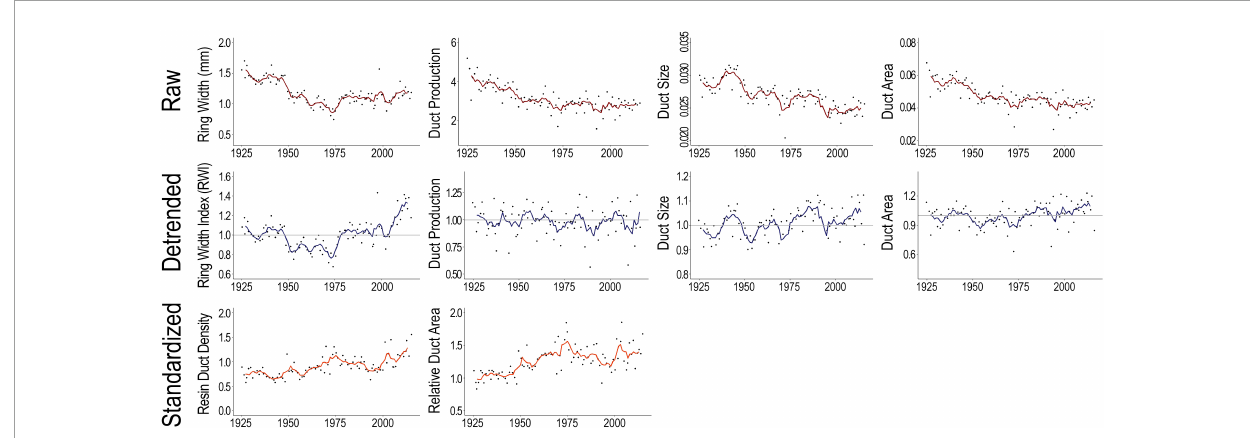
FIGURE2 Time series plots of raw tree-ring data (top row) , detrended data (middle) , and duct metrics that have been standardized to tree growth (bottom row) . Tree growth (ring-widths: mm), resin duct production (no. ducts year - 1 ), duct size (mm 2 ), duct area (mm 2 year - 1 ), and resin duct metrics that have been standardized to tree growth: duct density (no. ducts mm - 2 year - 1 ) and relative duct area (% annual ring). Smoothed lines in the time series plots represent 5-year moving